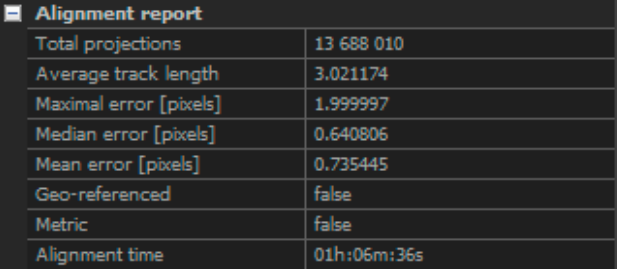
Figure A4. Alignment Report for Room 19.